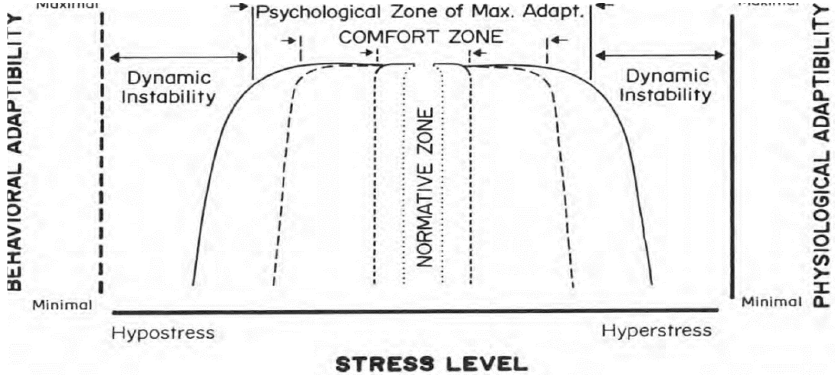
Figure 6. Relation between different types of stress and the psychologically adaptable comfort zone [49].